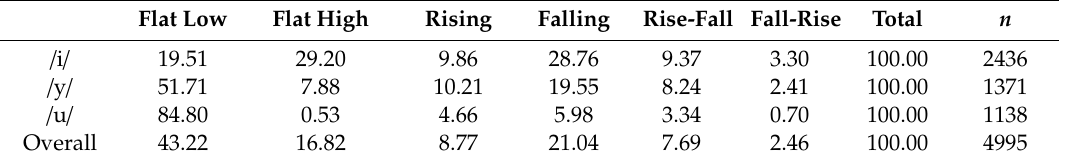
Table 6. Profile distribution by vowel, expressed in % of each